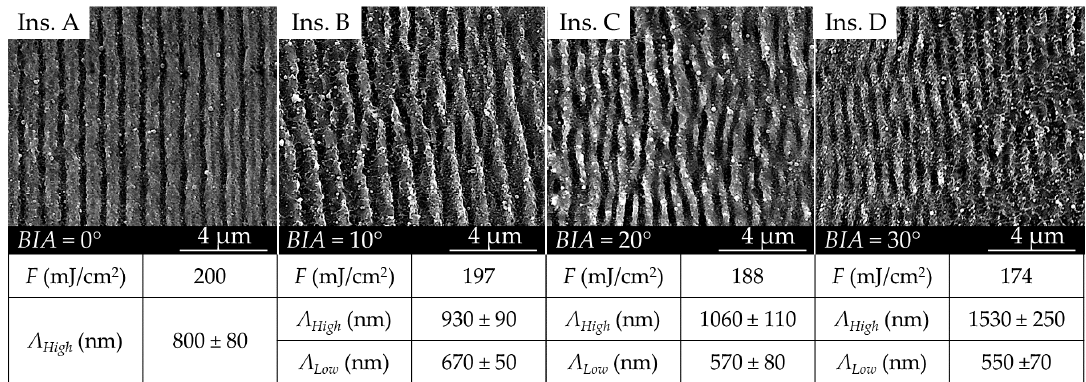
Figure 5. SEM micrographs of the textured surfaces on the steel mold inserts for di ff erent beam incidence angles ( BIA s).